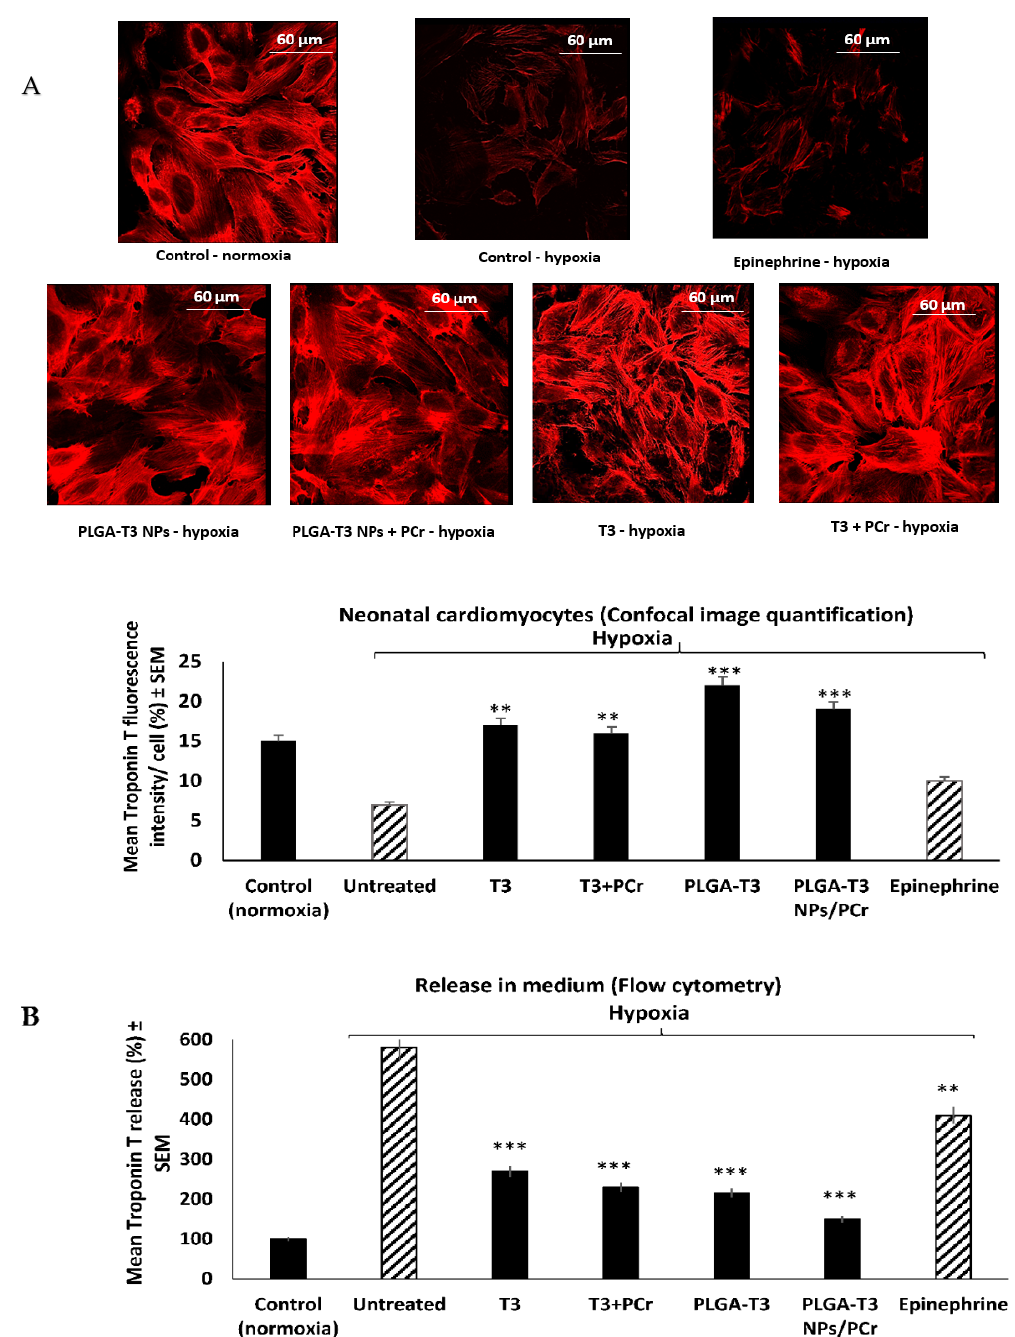
Figure 6. Expression of troponin T in neonatal cardiomyocytes under hypoxic condition. ( A ) Im- munostaining by anti-troponin T-PE (confocal microscopy). ( B ) Quantitation of troponin T in neonatal cardiomyocyte and in medium. ** p < 0.05, *** p < 0.001 versus untreated control, with full reversal and improvement versus control under normoxic condition. These results suggest that PLGA-T3 NPs and PLGA-T3 NPs/PCr inhibit the damaging effect of hypoxia on cardiomyocytes.